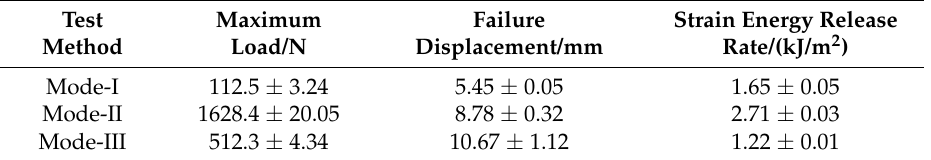
Table 5. Interlaminate parameters of WGF/epoxy composites calculated from fracture toughness tests.